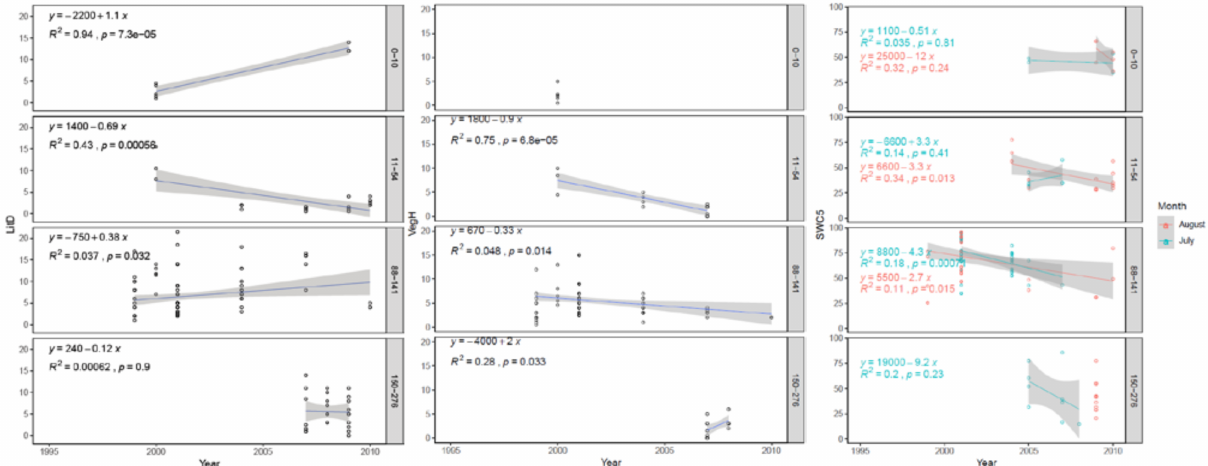
Figure A2. Litter thickness (LitD, cm), vegetation cover height (VegH, cm), and soil water content (SWC5, %) at wildfire- affected sites of different ages in the 1995–2010 study period. Grey areas represent standard errors. The figure in the grey bar at the right side indicates the age interval of larch stands.